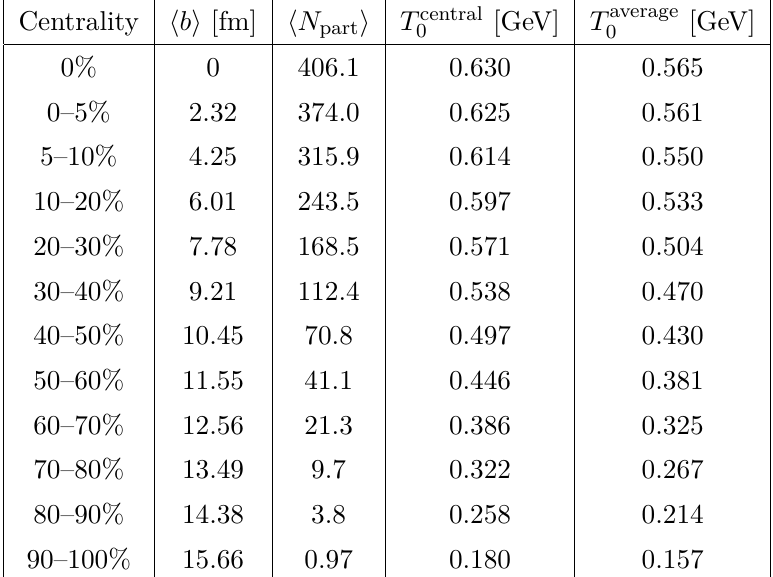
√ s NN = 5 . 02 TeV PbPb